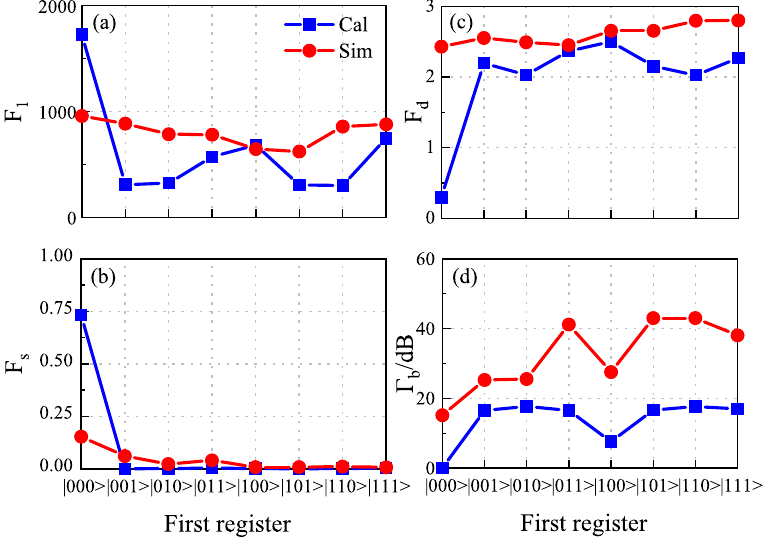
Figure A6. Comparison between the 1-fidelity F 1 , state-fidelity F s , and trace distance F d with Γ b . Blue curves represent the calculated results and the red curves are the simulated results by the “qasm simulator” in